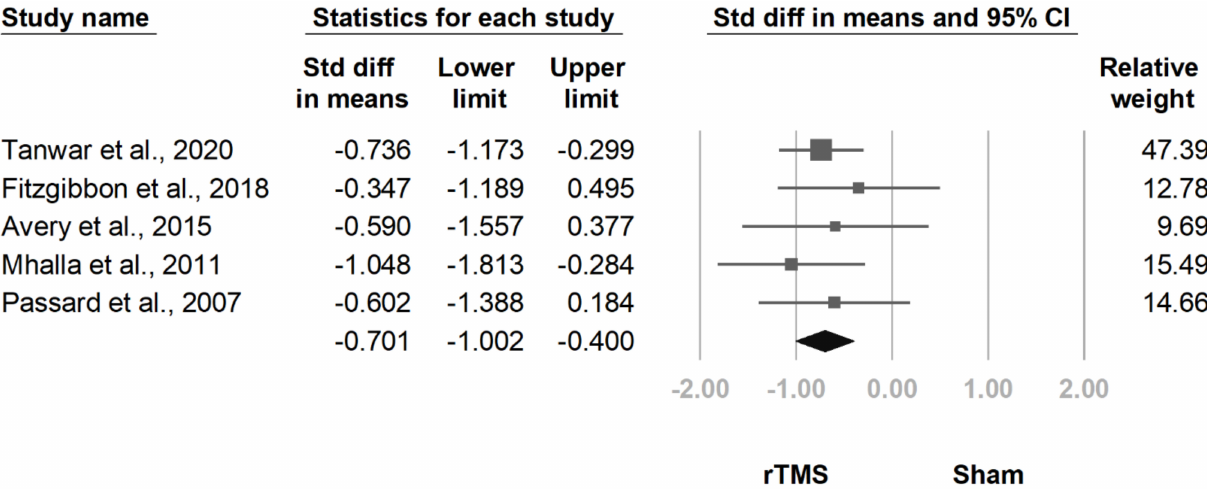
Figure 12. Forest plot of standardized mean differences in McGill Pain Questionnaire at follow-up at 2 weeks to 1 month after last treatment session. Squares indicate effect sizes of individual studies, lines indicate 95% CI, and diamond indicates the summarized effect